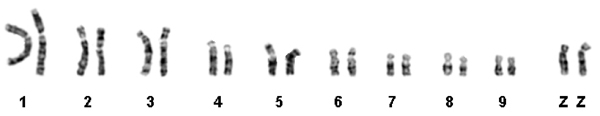
G-banded chromosomes 1–9 and Z from the sparrow. G-banded chromosomes 1–9 and Z from a 2m/2 3a/3 white-throated sparrow (KB15794; San Diego Zoo's Institute for Conservation Research, Zoological Society of San Diego).